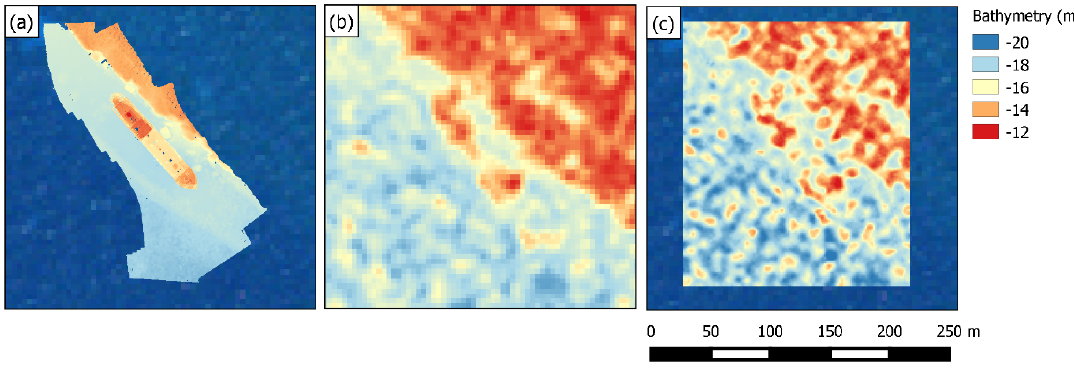
Figure 15: Density scatter plot comparing field-measured bathymetry (x-axis) and satellite bathymetry (y-axis) over the Elphis I wreck using the original resolution image (left) and the pan-sharpened image (right). Brighter colours indicate higher density of points, darker colours lower density.